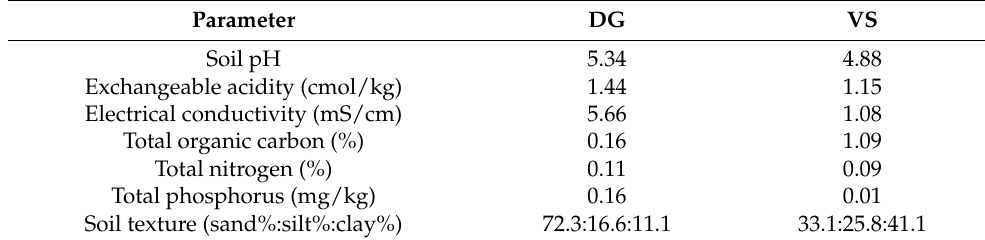
Table 2. Chemical composition of waterworks sludge used in this